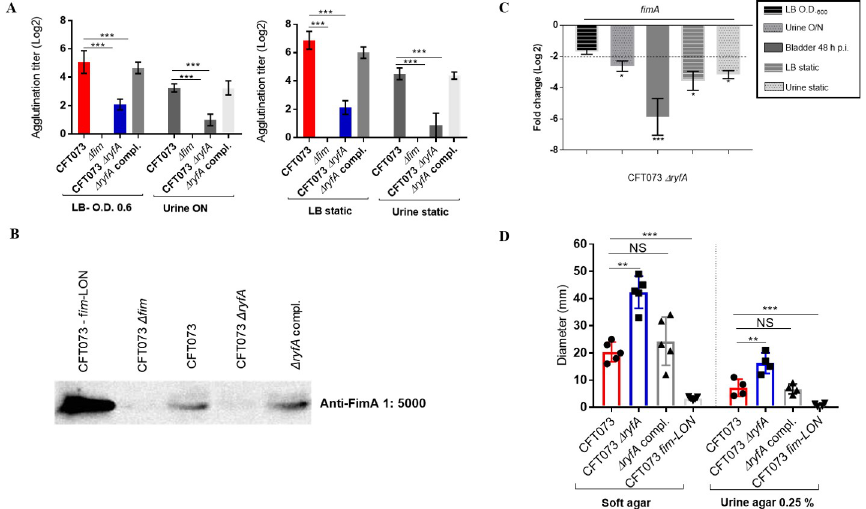
Fig 4. Effect of deletion of ryfA on type 1 fimbriae (pili) production and motility. ( A ) Yeast agglutination titer demonstrating level of production of type 1 fimbriae in strains cultured to the mid-log phase and after overnight static growth in LB broth and in human urine. The Δ fim strain was used as a negative control and showed no agglutination. ( B ) Western blot of fimbrial extracts of strains cultured to the mid-log phase of growth in LB broth. The CFT073 fim- locked ON strain was used as a positive control. ( C ) Expression of fimA gene by qRT-PCR in the Δ ryfA strain compared to the WT CFT073 strain in LB, human urine and infected bladders. ( D ) Motility of CFT073, ryfA mutant and complemented strain on 0.25% soft or urine agar. Each box and scatter dot plot (min to max) represents the mean diameter of the motility zone. Results are the mean values and standard deviations for at least three biological experiments. Statistical significance was calculated by the Student t test (A, C, D): � , P < 0.05; �� , P < 0.005; ��� , P < 0.0001. NS, not significant.